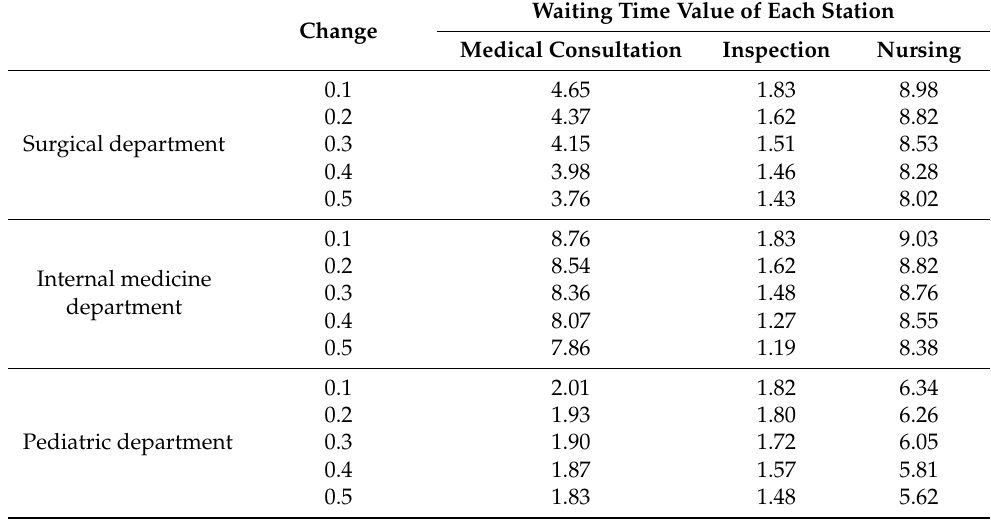
Table 5. Effects of different dispersion